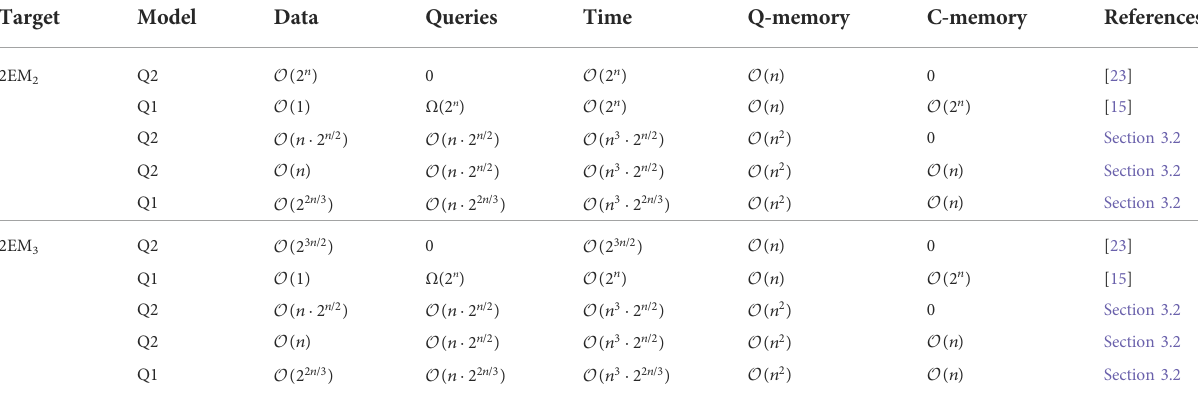
TABLE 1 Comparison of previous quantum attacks and our attacks on 2EM 2 and 2EM 3 constructions, where “ Data ” represents encryption queries, “ Queries ” signi fi es calls to P i , “ Q-memory ” and “ C-memory ” denote quantum memory and classical memory respectively.